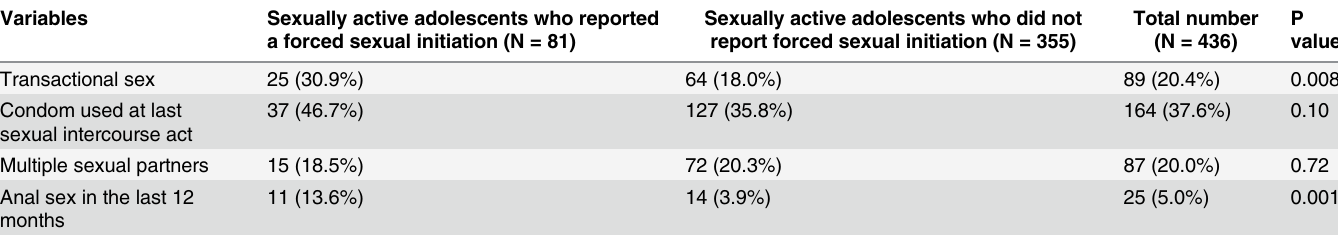
Table 2. History of forced sexual initiation and HIV-risk sexual behavior.